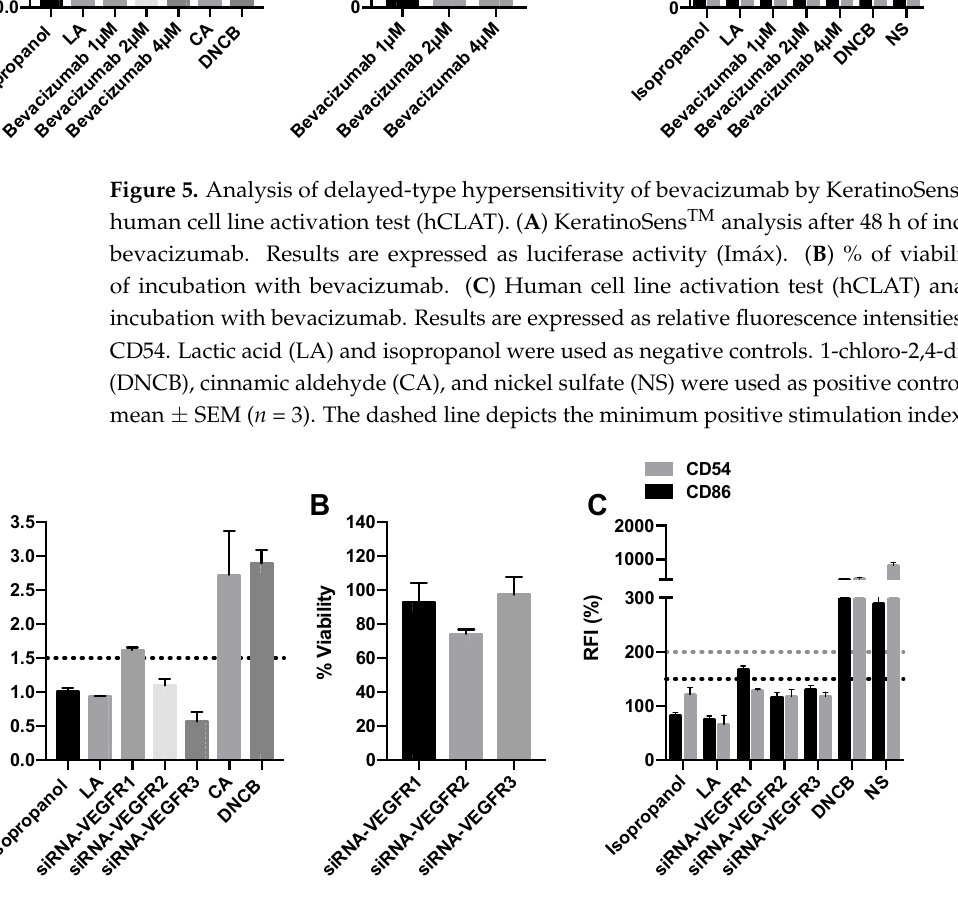
Figure 5 . Analysis of delayed-type hypersensitivity of bevacizumab by KeratinoSens TM assay and human cell line activation test (hCLAT). ( A ) KeratinoSens TM analysis after 48 h of incubation with bevacizumab. Results are expressed as luciferase activity (Imáx). ( B ) % of viability after 48 h of in- cubation with bevacizumab. ( C ) Human cell line activation test (hCLAT) analysis 48 h of incubation with bevacizumab. Results are expressed as relative fluorescence intensities of CD86 and CD54. Lactic acid (LA) and isopropanol were used as negative controls. 1-chloro-2,4-dinitrobenzene (DNCB), cinnamic aldehyde (CA), and nickel sulfate (NS) were used as positive controls. Shown are mean ± SEM ( n = 3). The dashed line depicts the minimum positive stimulation index.